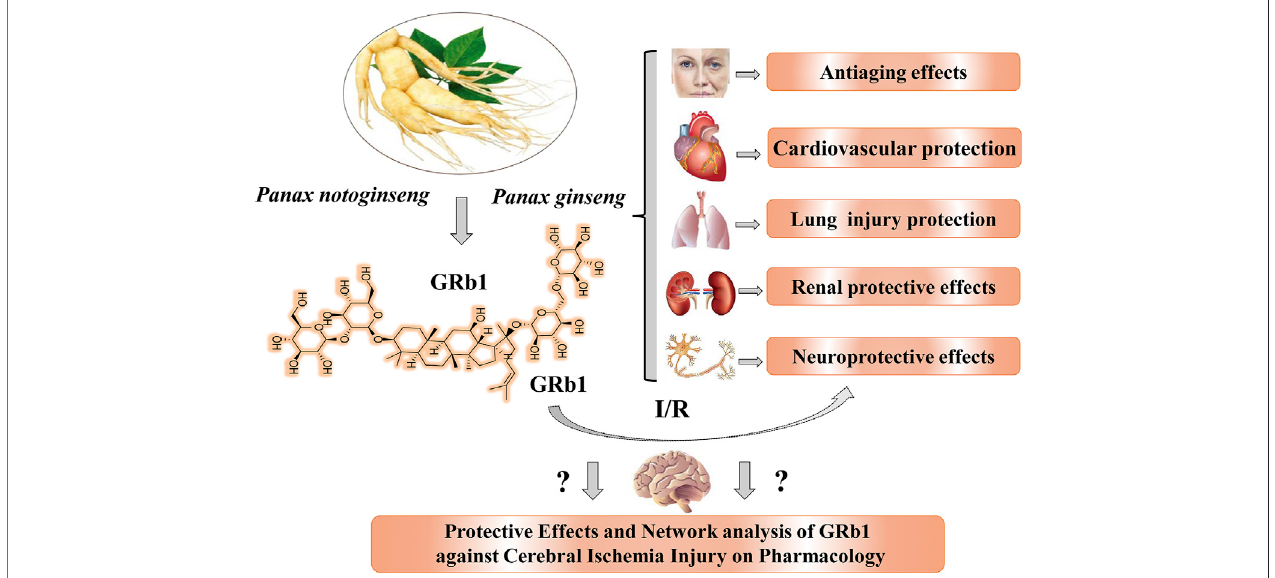
FIGURE 1 | Natural sources, chemical structure, and main pharmacological activities of ginsenoside Rb1 obtained from P. notoginseng and P. ginseng . GRb1 exerts signi fi cant neuroprotective effects, but its ef fi ciency and action network must be further explored and analyzed. GRb1, ginsenoside Rb1; I/R, indicates ischemia and